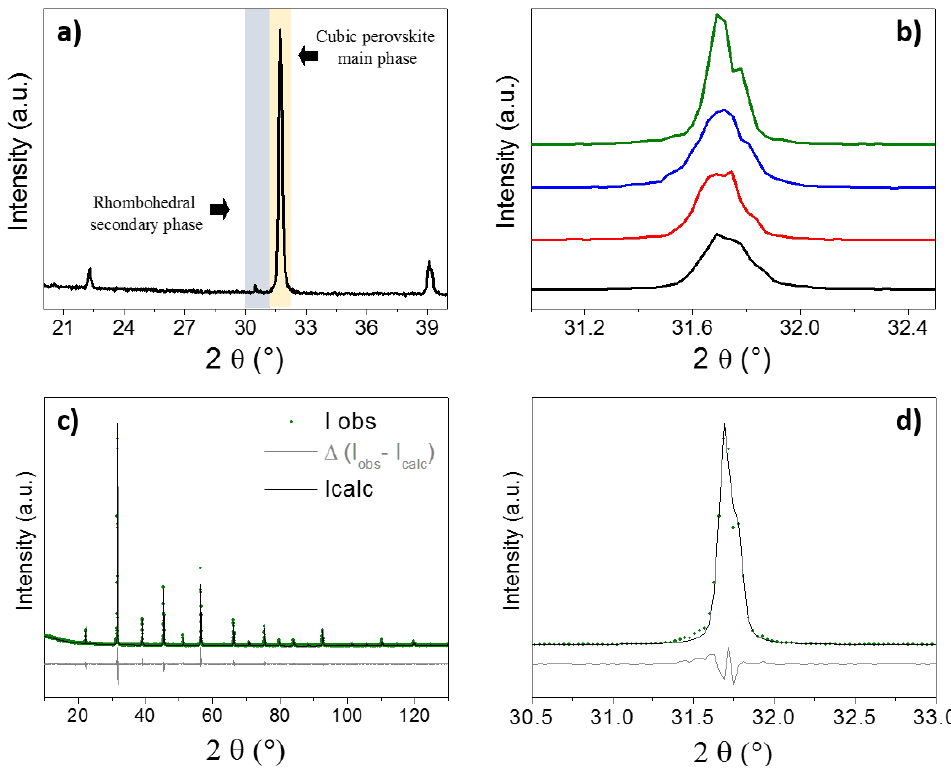
Figure 3. ( a ) Inset of the XRD pattern of BSCF10 after thermal treatment at 1100 °C for 2 h; ( b ) inset of the perovskite phase’s main peak in the 31–32.5° 2θ angular range of the XRD patterns of BSCF10 (black), BSCF17 (red), BSCF22 (blue) and BSCF31 (green) thermally treated at 1100 °C for 2 h; ( c ) Rietveld refinement of the XRD pattern of BSCF31 treated at 1100 °C for 2 h: XRD data (olive green dots), model (black line) and residual (grey line); ( d ) inset of the fitting in the region of the perovskite phase’s main peak.